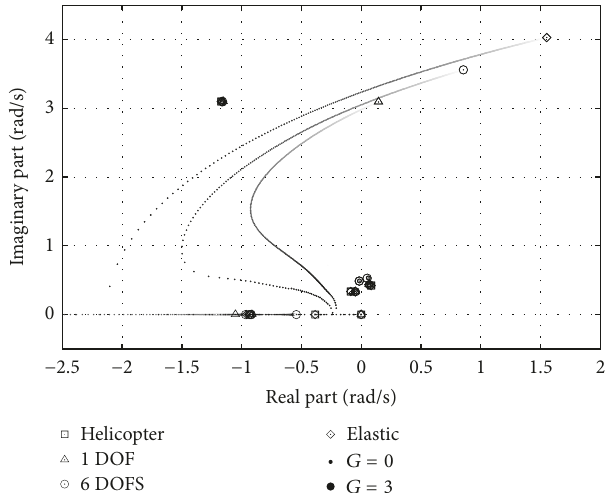
Figure 17: Influence of helicopter dynamic modeling on active pilot in the loop,